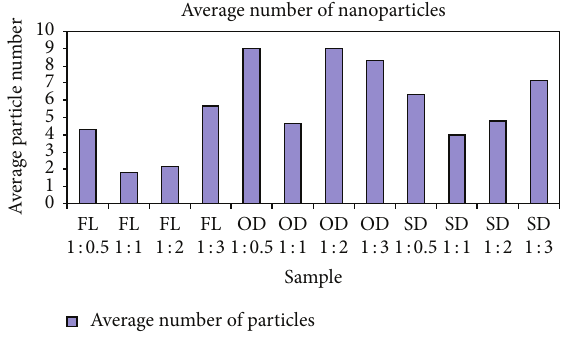
Figure 7: Average width of silver nanoparticles synthesized from the leaf extracts of Pimenta dioica under different conditions.